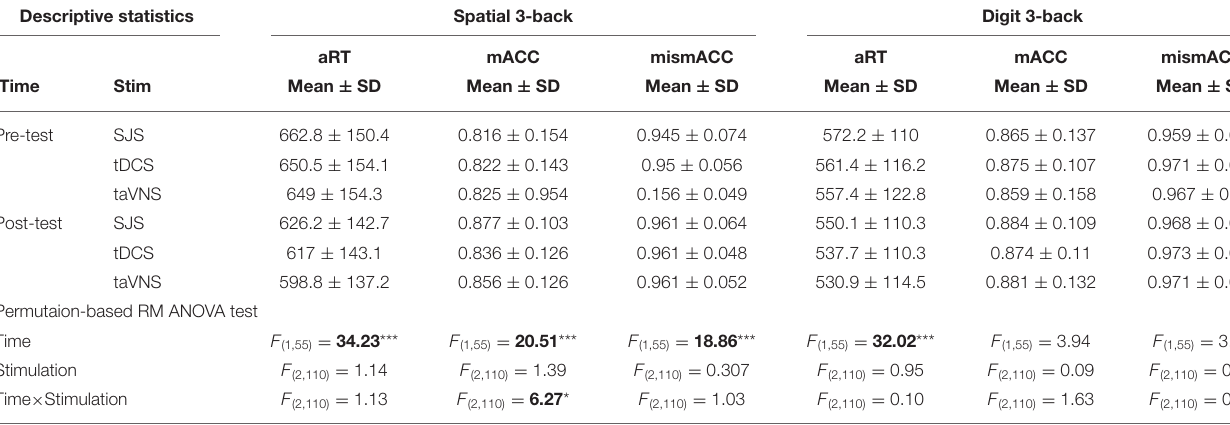
TABLE 1 | Means, standard deviations, and two-way ANOVA results of WM tasks in experiment 1. Descriptive statistics